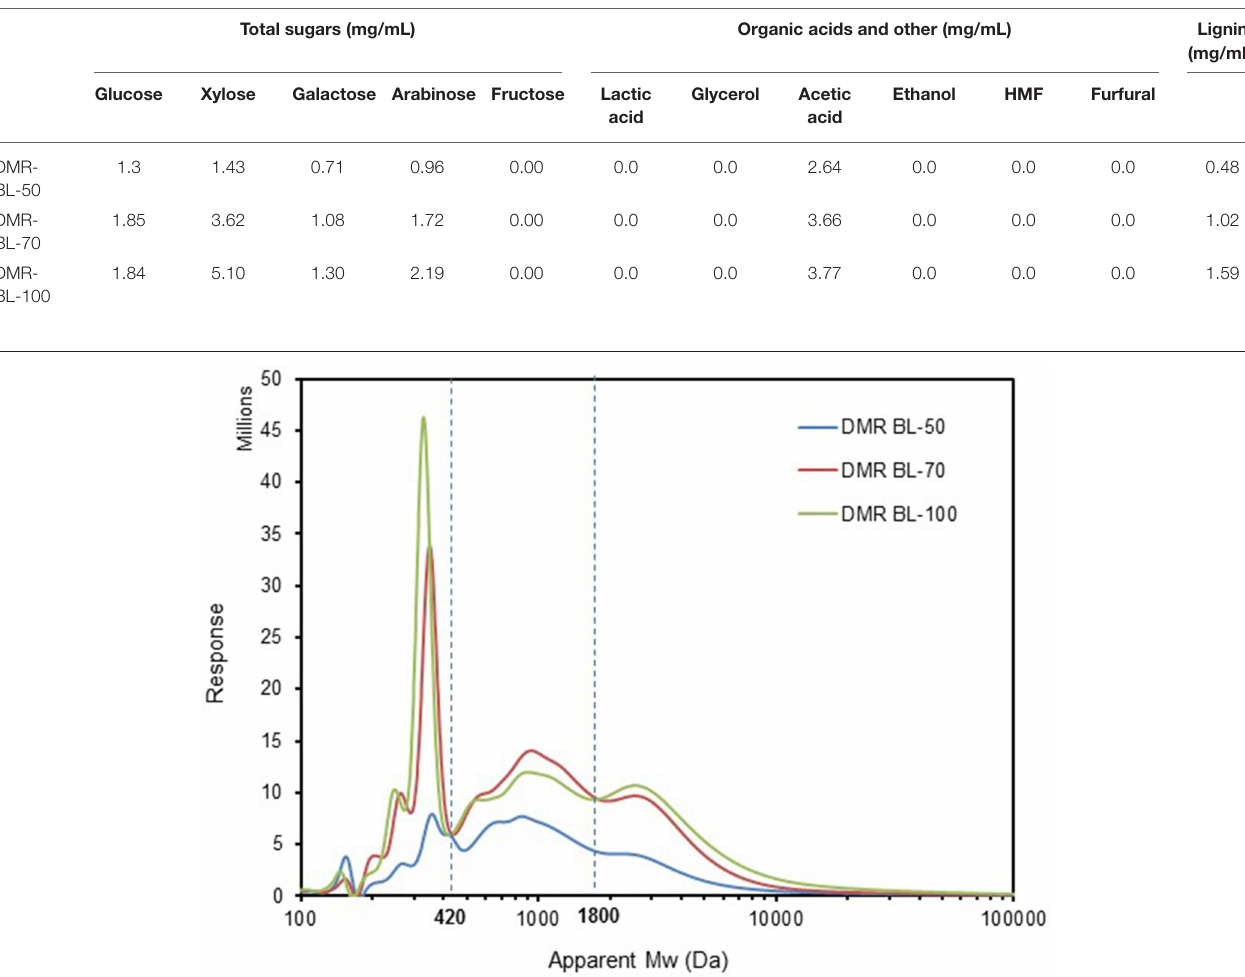
TABLE 1 | Compositional data of the black liquors from deacetylation process.